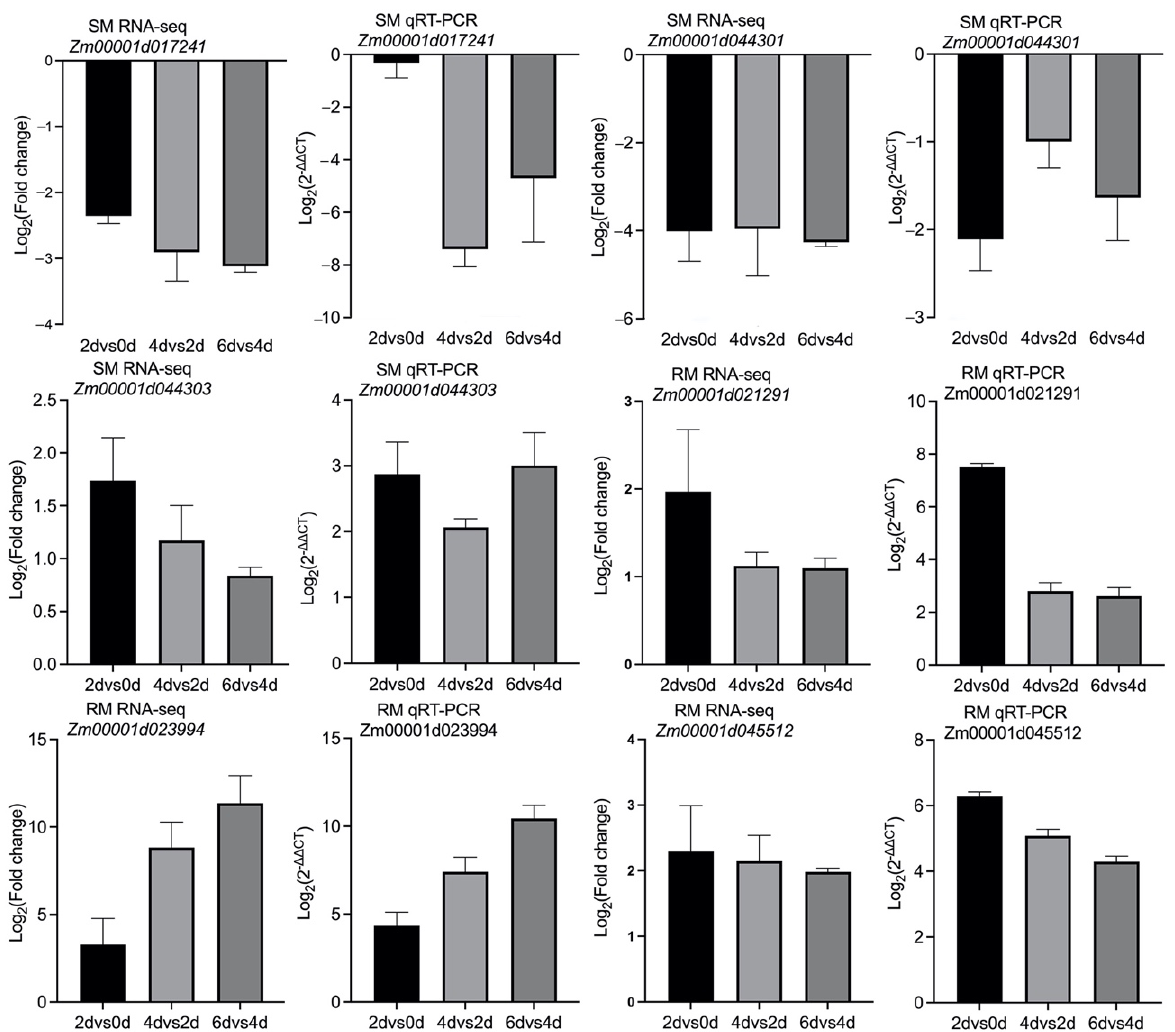
Figure 5. Validation of RNA-seq data by qRT-PCR. The qRT-PCR data were normalized against the internal reference gene data. The RNA-seq and qRT-PCR data are presented on the left and right, respectively.